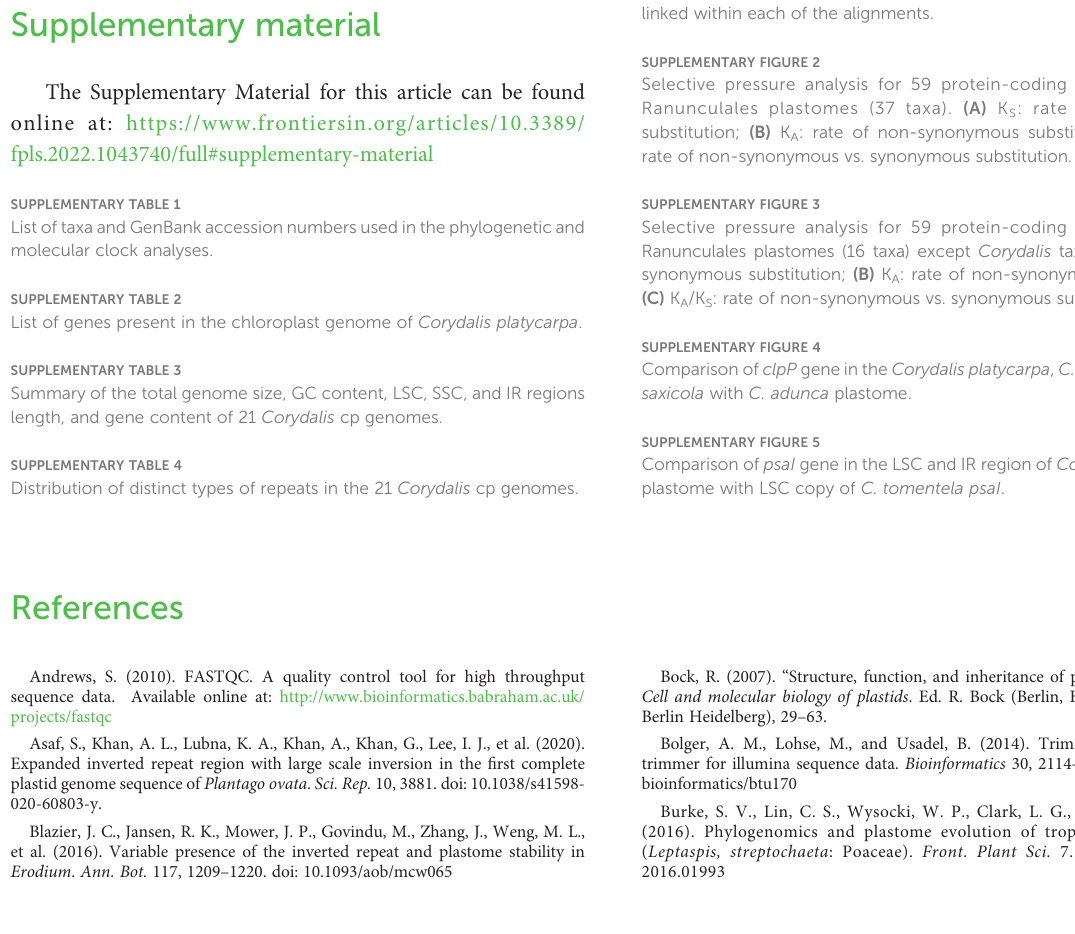
SUPPLEMENTARY TABLE 9 Comparison of site models, positive selective amino acid loci, and estimation of parameters for 24 protein-coding genes in the Corydalis species. SUPPLEMENTARY TABLE 10 List of pseudogenes and lost genes in the 21 Corydalis plastomes. SUPPLEMENTARY TABLE 11 List of Corydalis plants distribution areas. SUPPLEMENTARY FIGURE 1 MAUVE alignment of Ranunculales plastomes using Geneious Prime. Local collinear blocks are represented by blocks of the same color and linked within each of the alignments. SUPPLEMENTARY FIGURE 2 Selective pressure analysis for 59 protein-coding genes of all the Ranunculales plastomes (37 taxa). (A) K S : rate of synonymous substitution; (B) K A : rate of non-synonymous substitution; (C) K A /K S : rate of non-synonymous vs. synonymous substitution. SUPPLEMENTARY FIGURE 3 Selective pressure analysis for 59 protein-coding genes of all the Ranunculales plastomes (16 taxa) except Corydalis taxa. (A) K S : rate of synonymous substitution; (B) K A : rate of non-synonymous substitution; (C) K A /K S : rate of non-synonymous vs. synonymous substitution. SUPPLEMENTARY FIGURE 4 Comparison of clpP genein the Corydalis platycarpa , C. fangshanensis , C. saxicola with C. adunca plastome. SUPPLEMENTARY FIGURE 5 Comparison of psaI gene in the LSC and IR region of Corydalis platycarpa plastome with LSC copy of C. tomentela psaI